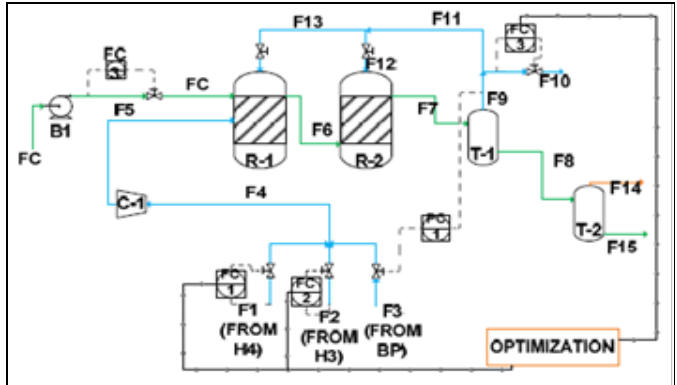
Figure 8: Diagram of a HDS plant. Source: Authors, (2018).